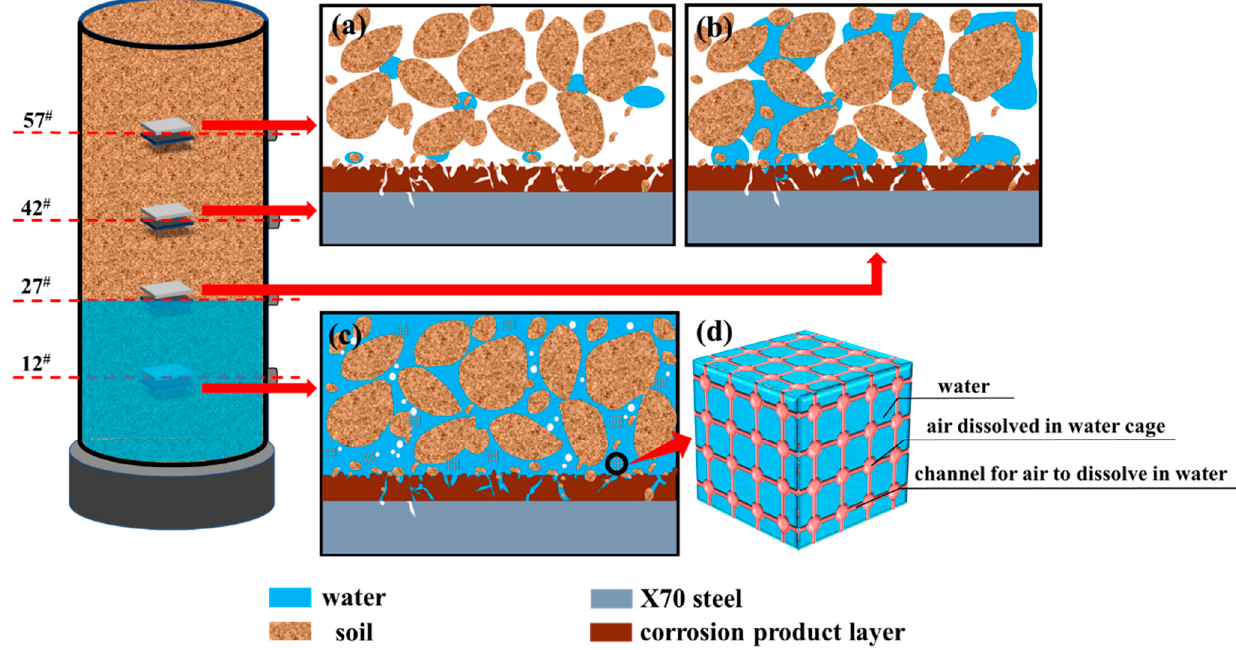
Figure 20. Morphological changes of solid-liquid-gas three-phase due to rising capillary water in Geo-experts one-dimensional soil column instrument X70 steel corrosion system:( a ) locations above the capillary water wetting front, ( b ) location of the capillary water wetting front, ( c ) locations below the capillary water wetting front, ( d ) the air dissolved in the water is stored in the grid structure with many eyelets.